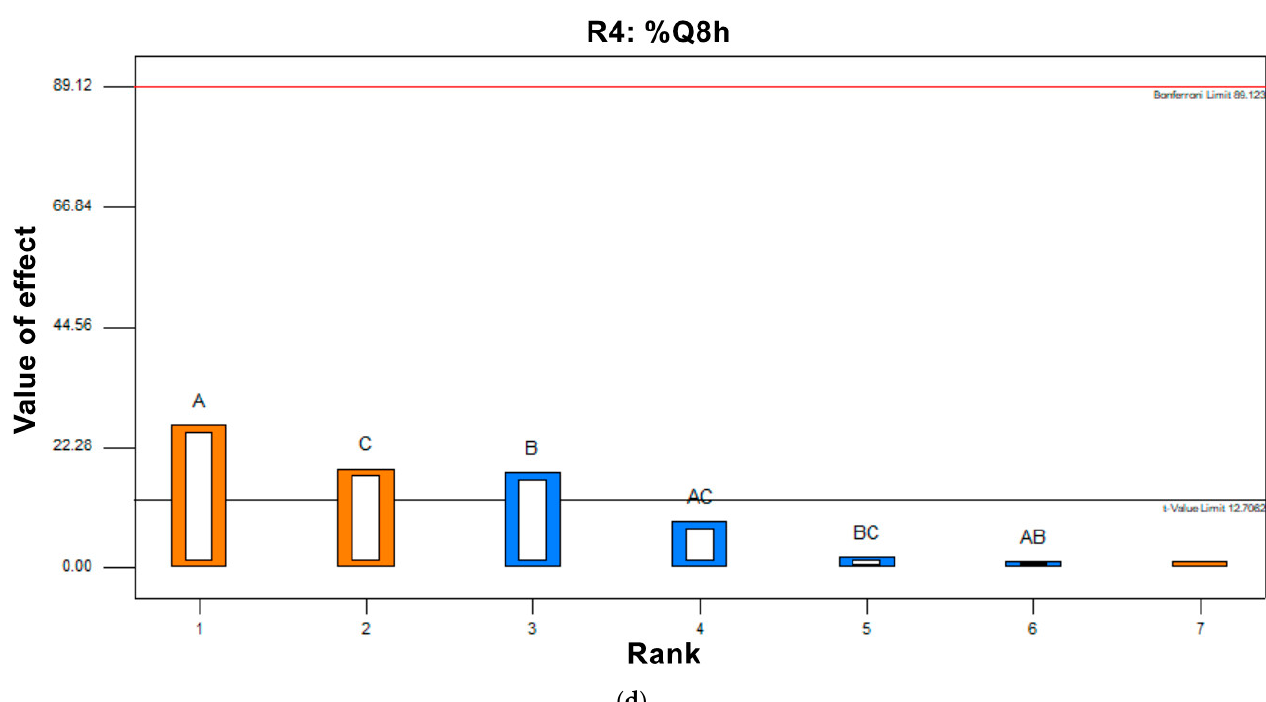
Figure 2. Pareto charts of the effect of independent variable (A) surfactant concentration, (B) CH:LP molar ratio, and (C) SDC concentration each variable alone or combined (AC), (AB) and (BC) on ( a ) R1 (VS), ( b ) R2 (EE%), ( c ) R3 (ZP), and ( d ) R4 (%Q8 h).